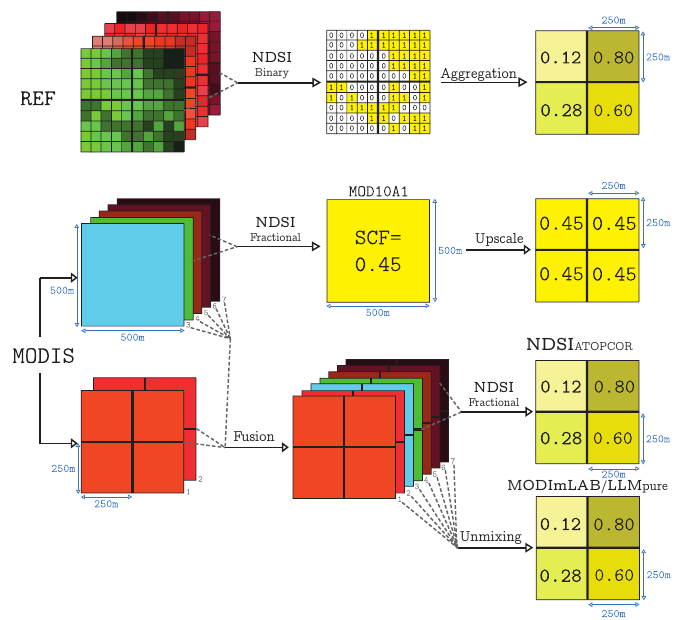
Figure 2. Workflow of the methodology used in this study to produce comparable maps of SCF at 250 m. The top line describes the aggregation methodology for the reference snow maps initially based on NDSI thresholding. The other lines details the methodology for the different products from MODIS data: from two of the five 500 m bands of MODIS for the MOD10A1 (based on NDSI linear regression) products at 500 m upscaled to 250 m (middle line), the seven fused bands of MODIS for MODImLAB and LMM pure (based on unmixing), and two of these fused bands for NDSI ATOPCOR (based on NDSI linear regression) (bottom